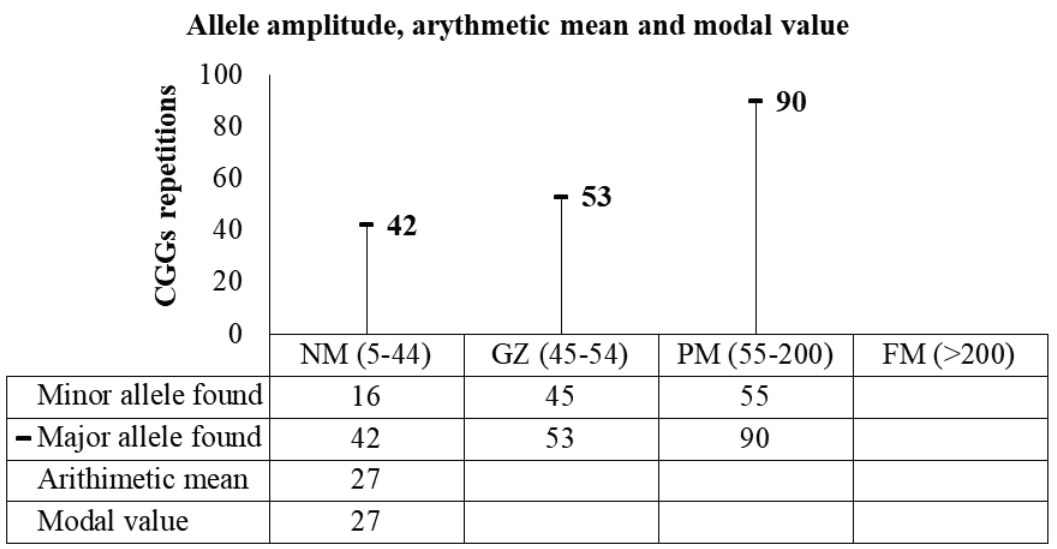
Figure 1 - the higher CGG repeat size found for the normal range was 42. For the grey-zone and premutation range were 53 and 90, respectively. the arithmetic mean and the modal value were both only calculated for the normal allele